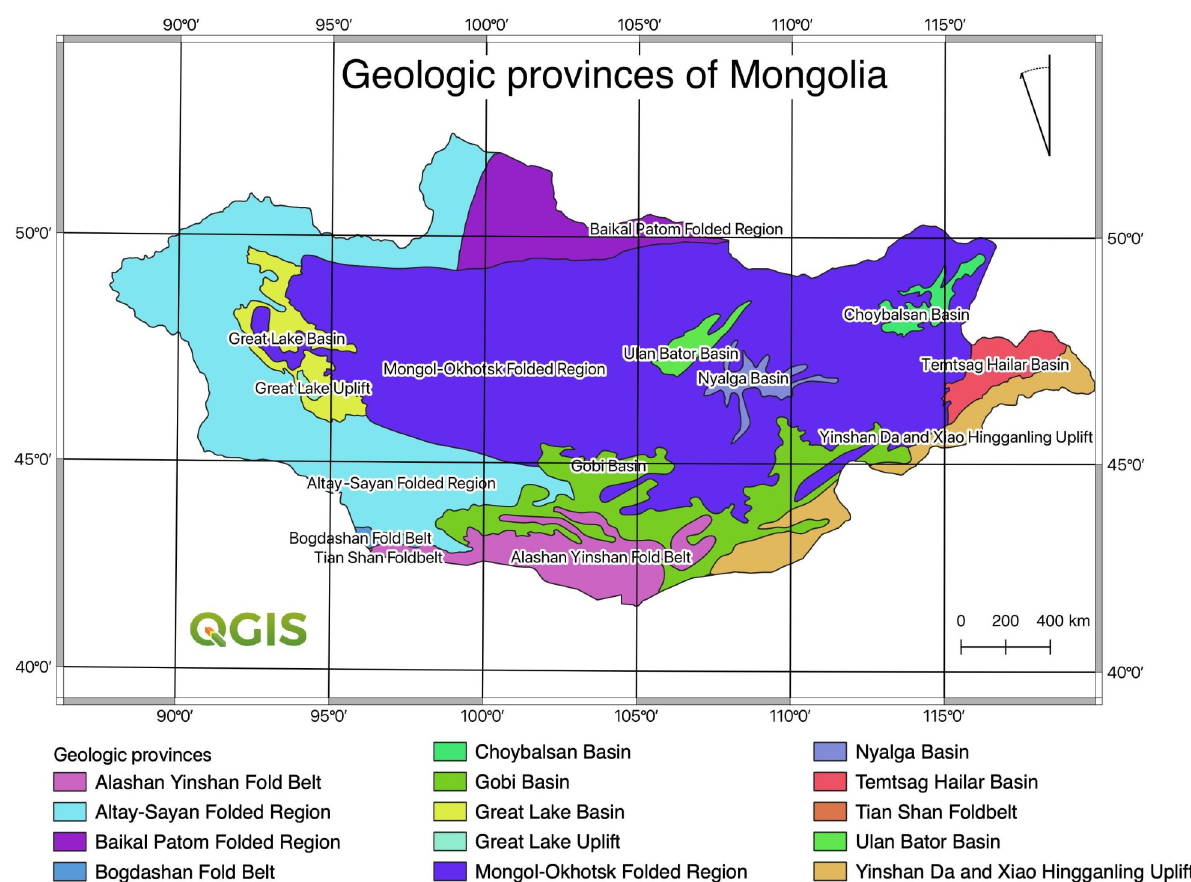
Fig. 2. Geologic provinces of Mongolia. Data: USGS geological survey. Mapping: QGIS. Source: